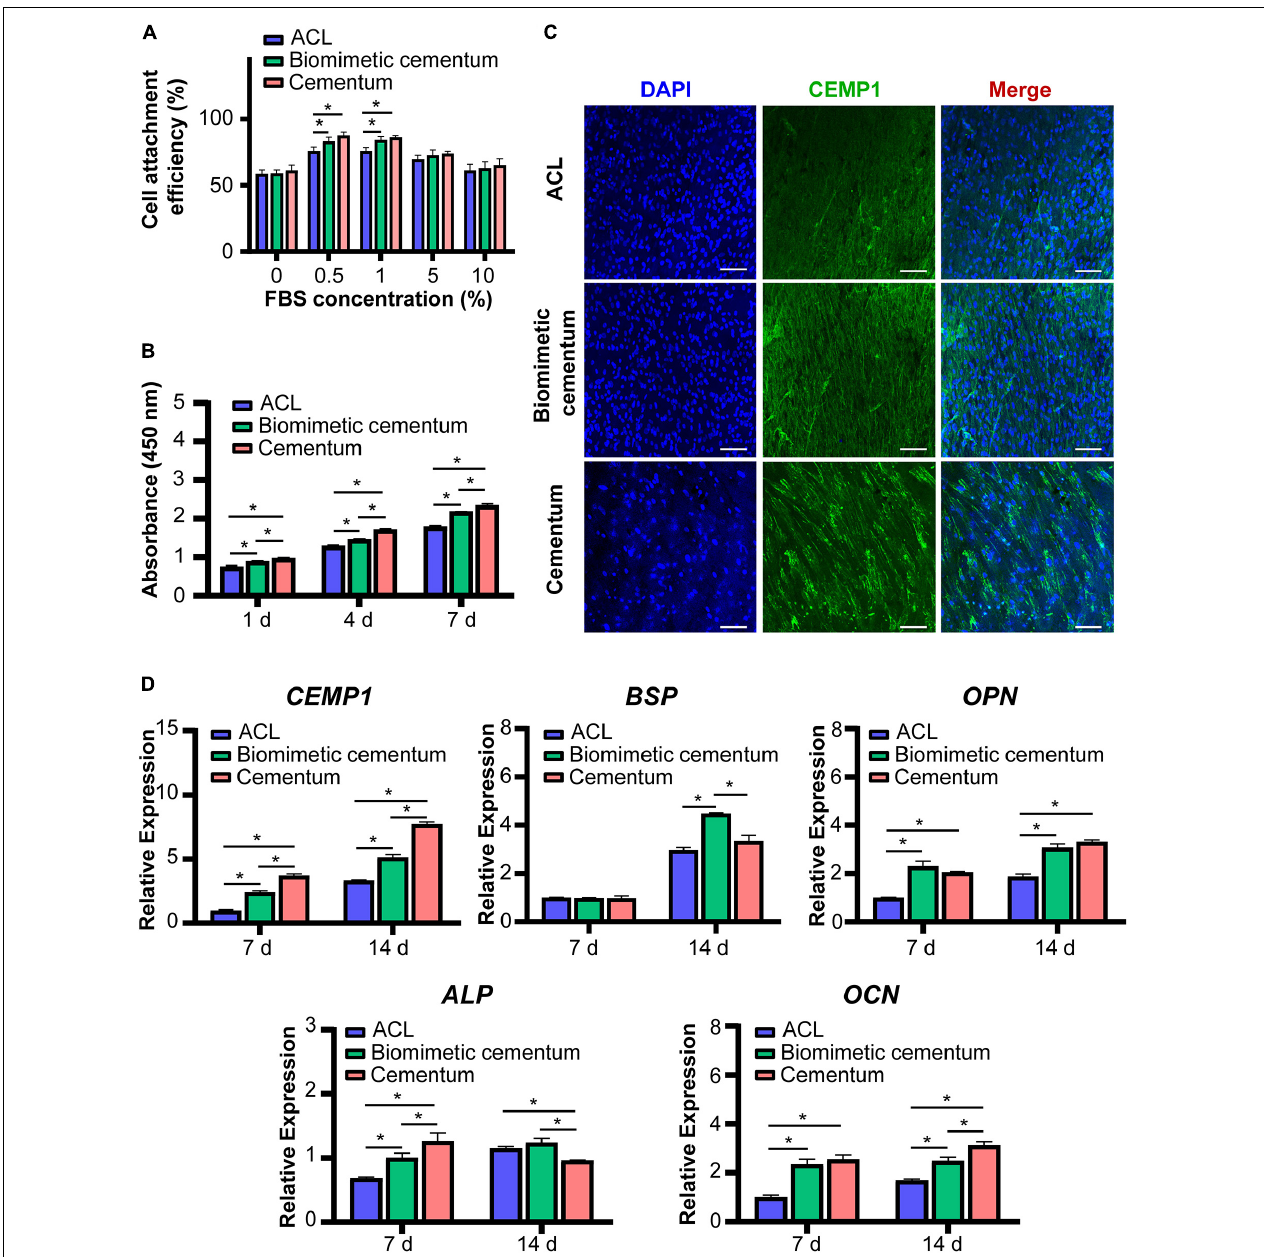
FIGURE 6 | The in vitro effect of biomimetic cementum on the PDLCs. (A) Cells adhesion under various concentrations of FBS. (B) Proliferation. (C) The immunofluorescent image of CEMP1 protein expressed in PDLCs after 14 days. Blue fluorescence represents nuclei and green fluorescence represents CEMP1. Scale bar: 100 µ m. (D) Gene expression results of CEMP1 , ALP , BSP , OPN , and OCN . Asterisk on top of each bar indicated statistically difference between groups ( p <